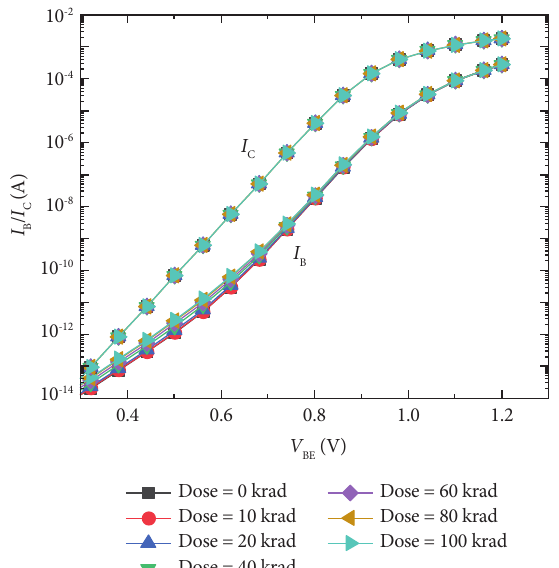
Figure 3: Gummel characteristics of NPN BJT after gamma rays